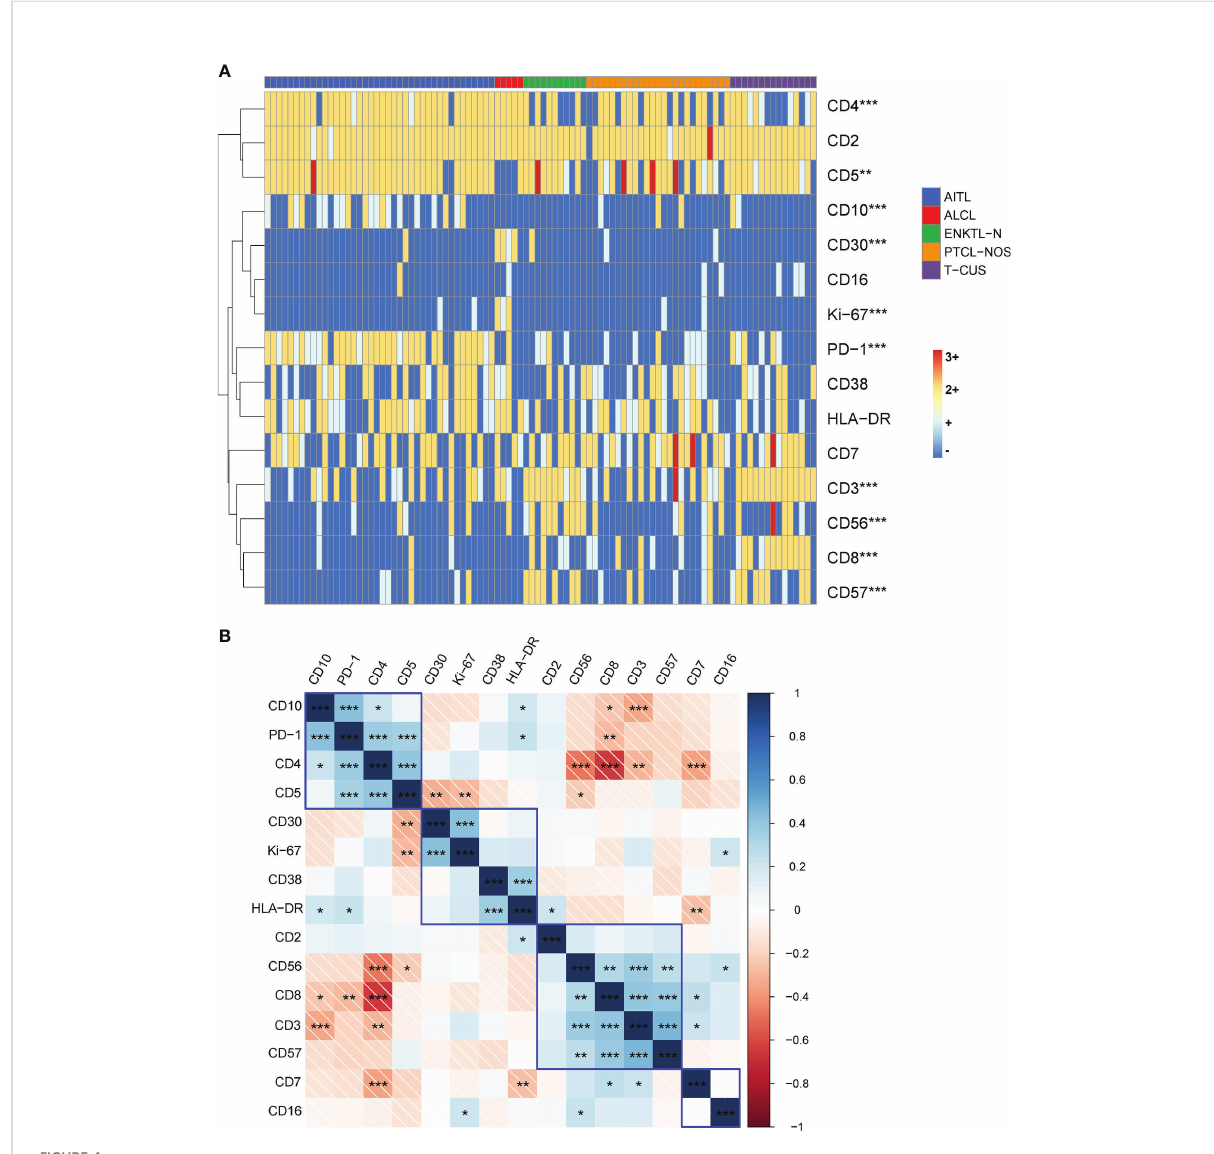
FIGURE 4 Immunophenotype-based cluster analysis of AITL, PTCL-NOS, ENKTL-N, ALCL, and T-CUS. (A) 15 immune markers of clonal T cells from patients with AITL (n=40), PTCL-NOS (n=25), ENKTL-N (n=11), ALCL (n=5), and T-CUS (n=15) clustering diagram. The horizontal axis represents individual patients, and the vertical axis represents immune markers. (B) Correlation matrix of immune markers of PTCLs. Pearson correlation matrix analyzes all possible correlations among 15 immune markers. (*p < 0.05, **p < 0.01, ***p <